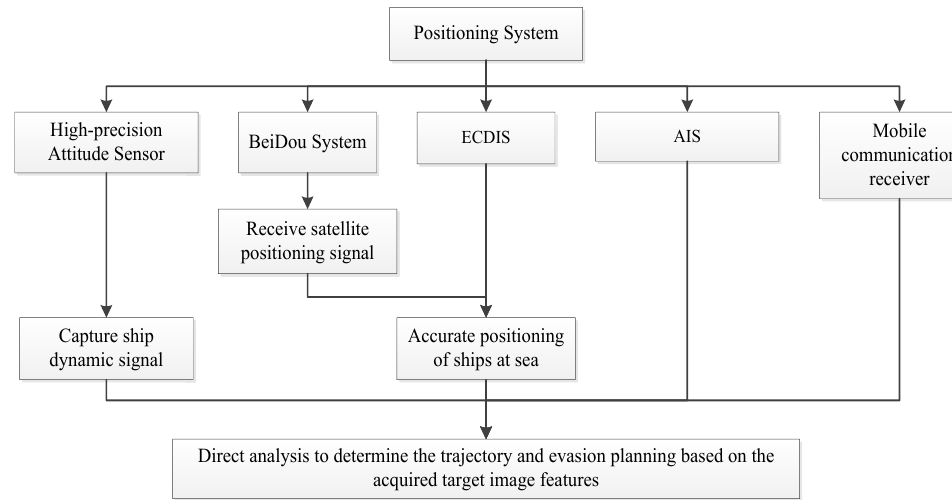
Figure 1. Schematic diagram of positioning system structure.